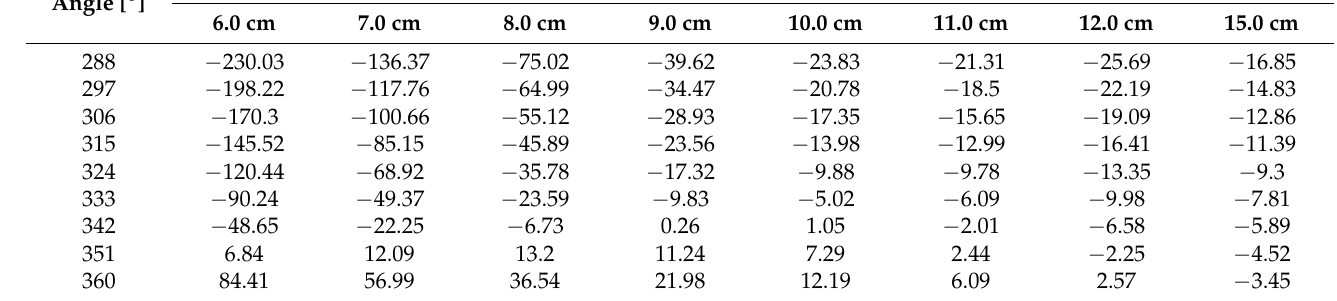
Table 9. Estimated values of the B z component of magnetic induction as a function of rotation angle and measurement